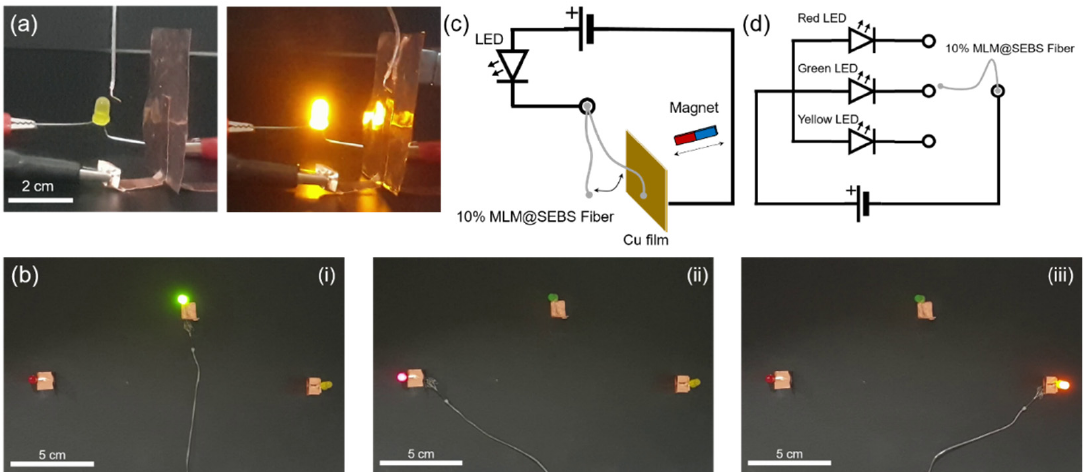
Figure 6. Electrical switching of a hollow elastic fiber with the MLM core containing 10 wt% of iron particles. ( a ) (left) Electrical circuit used for magnetic actuation of the SEBS fiber with the MLM core (MLM@SEBS fiber) before applying magnetic field, (right) LED activation by contacting the fiber with copper plate via remote magnetic actuation, ( b ) The fiber switched on ( i ) green LED, ( ii ) red LED, and ( iii ) yellow LED via remote magnetic actuation, ( c , d ) The electric circuit diagrams for ( a , b ), respectively.